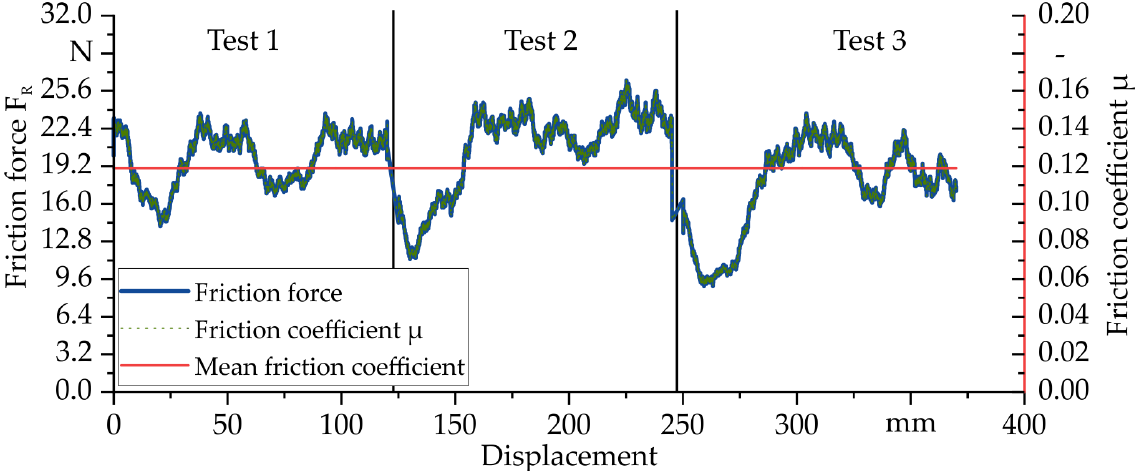
Figure 8. Diagram of the friction force/displacement curve and the corresponding and mean friction coefficient µ at 160°C for 1.2343 and